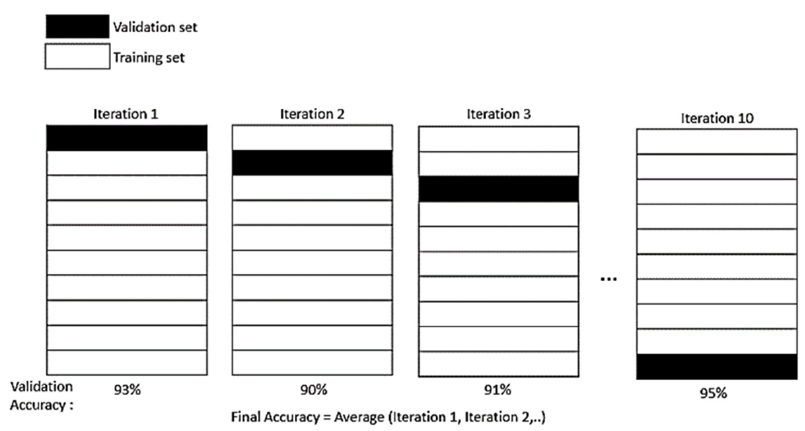
Figure 2. K − 1 fold CV method.